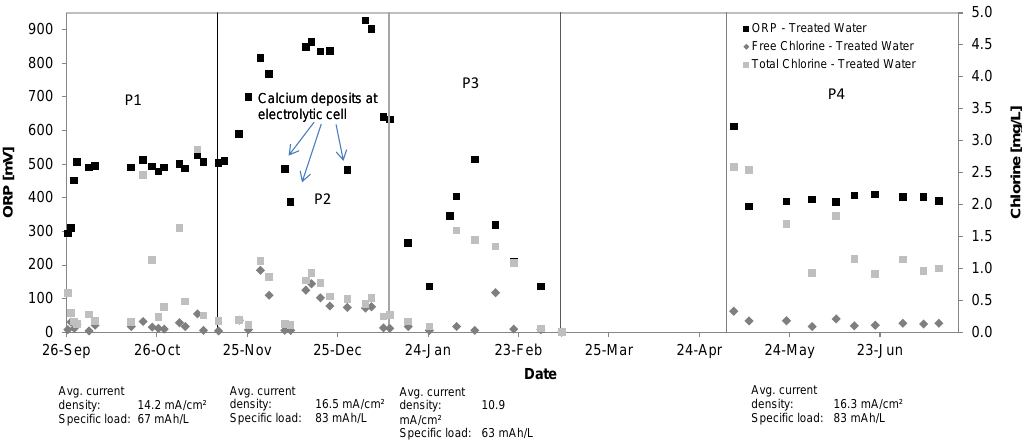
Figure 7. ORP, total and free chlorine concentrations in treated water, Kalyani pilot system, September 2016–July 2017.